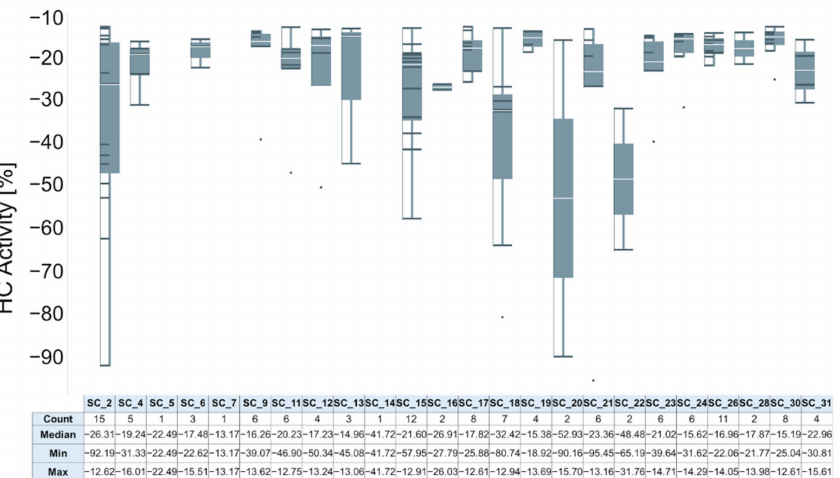
Figure 7. Distribution of activity percent within the scaffolds. In the box plot, a white line within the boxes marks the median value. Dots below the whiskers indicate outliers. For each scaffold, the numbers of hits, median, minimum, and maximum activity percent values are reported in the